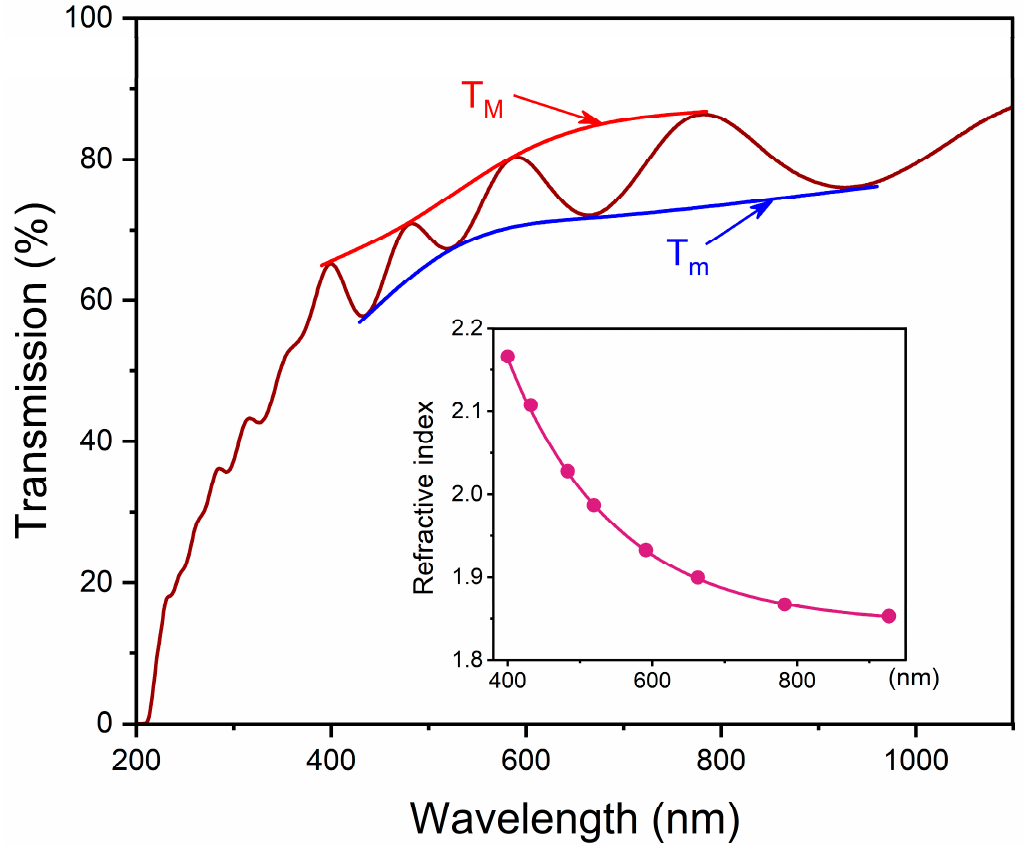
Figure 3. Optical transmission spectrum of Y 2 O 3 film (brown line). Red and blue lines show the upper T M and lower T m envelopes of the spectrum, respectively. Inset shows dispersion of the refractive index obtained by Swanepoel’s method [28]. The error of the refractive index is ±0.005. The values of the upper and lower “envelopes” are substituted in order to perform In the targeted range of the spectrum, magnetron-sputtered cubic Y 2 O 3 film produces calculations of the refractive index a higher refractive index when compared with that for Y 2 O 3 films synthesized with the use of other methods. For example, the refractive indices of cubic Y 2 O 3 films synthesized by means of radio frequency magnetron sputtering [15], electron beam deposition [16], and thermal evaporation [17] in the range of 400–800 nm are n = 1.95 − 1.91, n = 1.93 − 1.89, and n = 1.82 − 1.72, respectively. In addition, the Y 2 O 3 film inspected in our study exhibits a relatively high dispersion of the refractive index, which is larger in order of magnitude than that reported in the literature for other Y 2 O 3 films. It is known that refractive index where is related to the porosity and packing density of a material [30]. One can estimate the porosity ( P ) and packing density ( P d = 1 − P ) of the film using the known n for silica glass in the studied spectral range); substrate ( 469.1452.1 −= s )( λ T are the upper and lower “envelopes” of the optical transmission spectrum, respec- m tively. The measured refractive index for the wavelengths corresponds to interference ex- trema and is represented by the circles in the inset of Figure 3. Spectral dependence can be described using the simplified Cauchy equation (see violet line in the inset of Figure 3) [29]: where 𝐴 = 6.1 × 10 (cid:2872) ± 0.1 × 10 (cid:2872) is a constant and